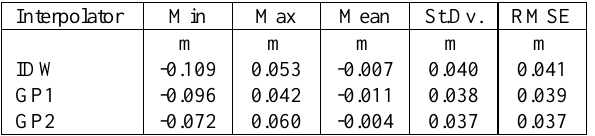
Table 3. Statistical values of the residuals obtained in 20 CPs in the case of GUMs based on 40 GNPs.